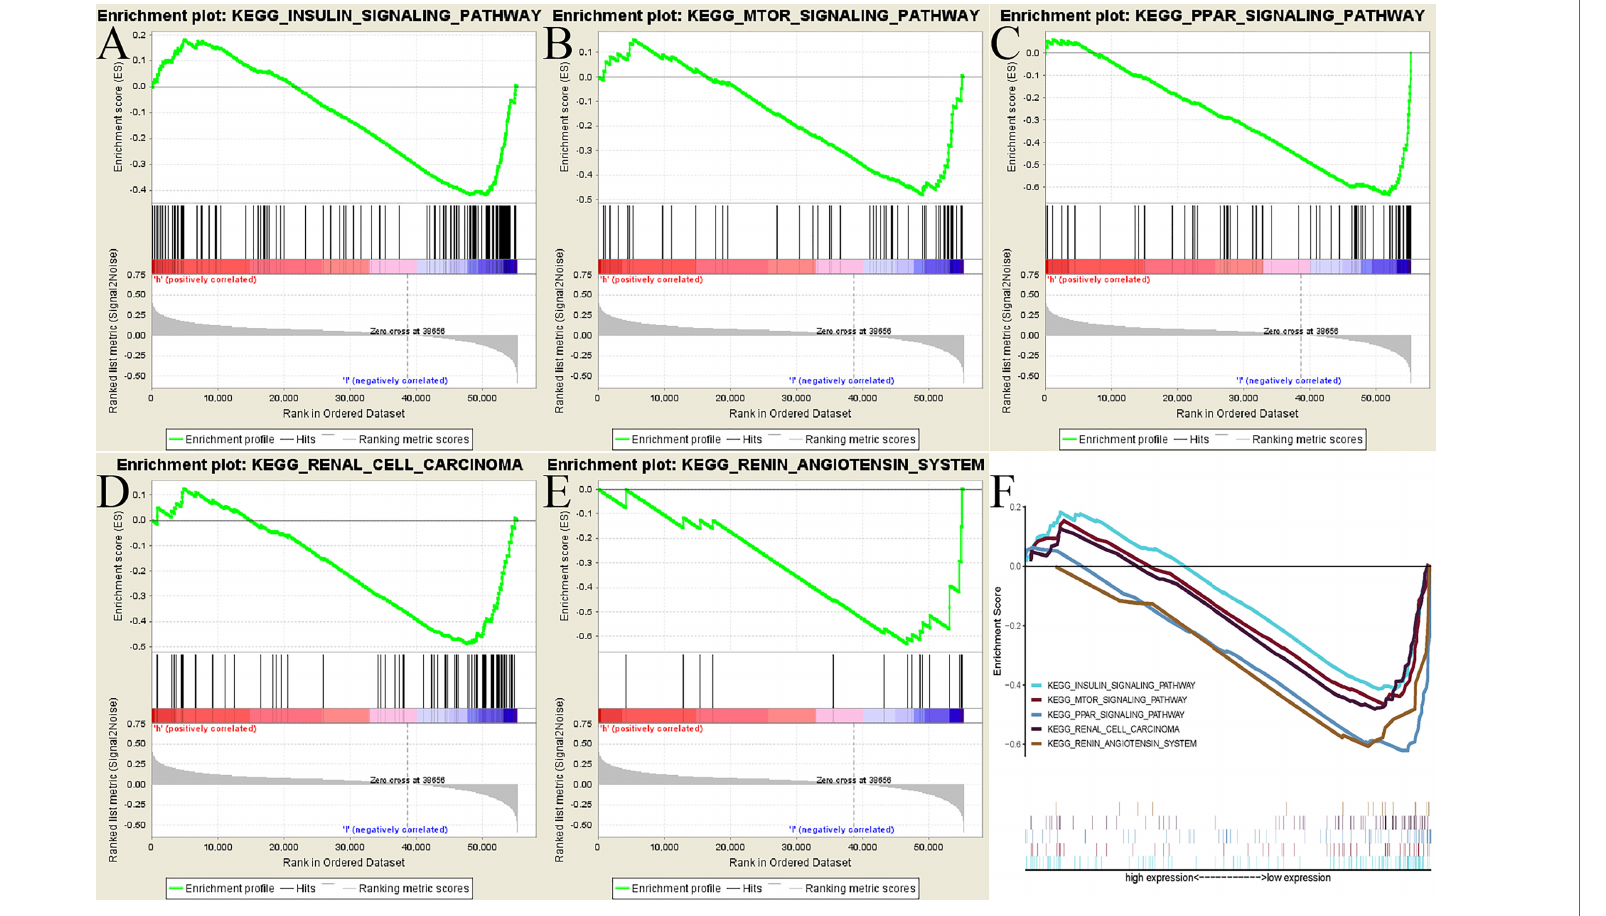
FIGURE 5 | GSEA identi fi ed ADAMTS14-related signaling pathways in TCGA dataset. (A) INSULIN signaling pathway. (B) MTOR signaling pathway. (C) PPAR signaling pathway. (D) Renal cell carcinoma signaling pathway. (E) Renin – angiotensin system signaling pathway. (F) All of these fi ve signi fi cantly enriched signaling